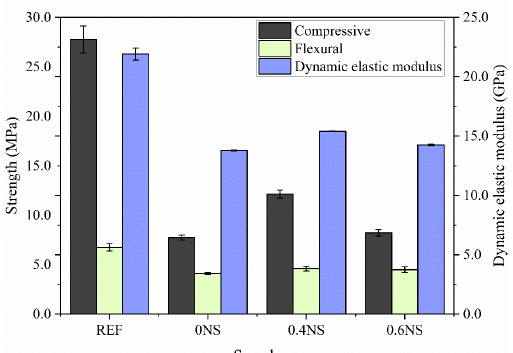
Figure 10. Mechanical properties of mortars produced with RFA and replacement of Portland cement by NS at 28 days.